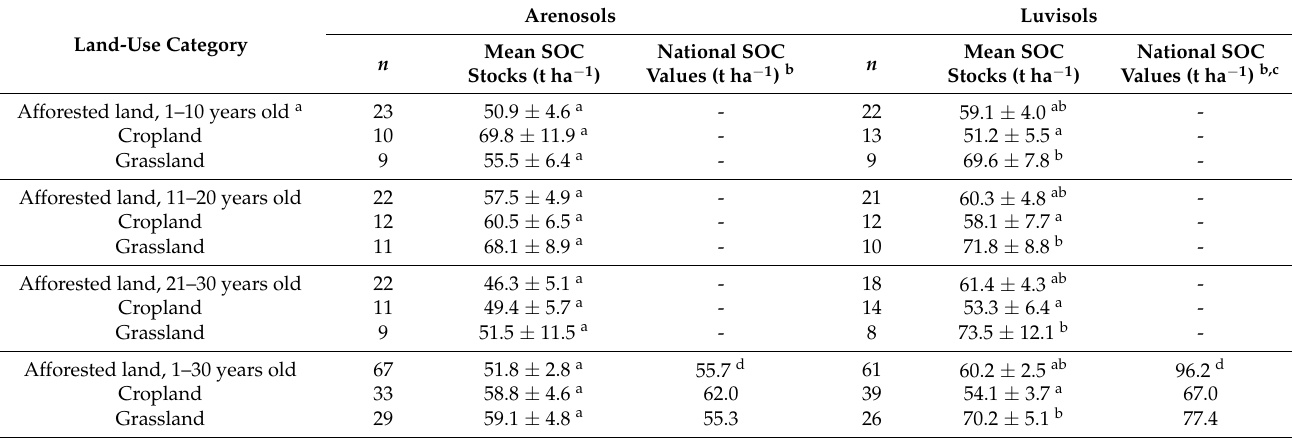
Table 5. Mean stocks (t ha − 1 ) of soil organic carbon (SOC) in 0–30 cm topsoil layers of Arenosols and Luvisols [47] in afforested land, cropland and grassland. Different letters a and b indicate significant differences between the land-use categories within each stand age decade for Arenosols and Luvisols at the p <